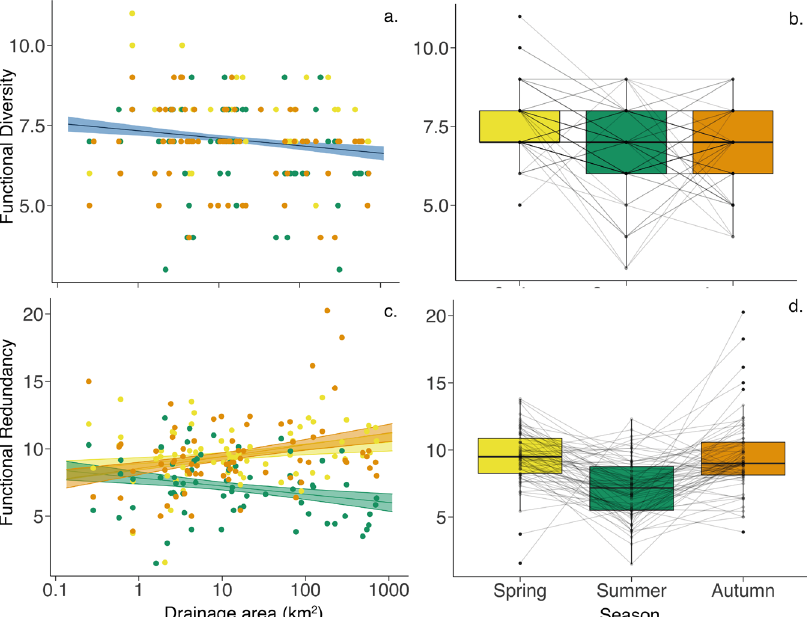
Fig. 5 Functional diversity and functional redundancy. Plots show functional dynamics: ( a , b ) functional diversity and ( c , d ) functional redundancy. Lines indicate linear mixed-effect models with shaded area showing 95% con fi dence intervals as calculated using the model predictions and standard error. Plot a shows no signi fi cant effect of the interaction between drainage area and season therefore the line indicates the model output of all the data as a function of drainage area which is marginally signi fi cant (blue). Plot c shows the model with a signi fi cant interaction with the difference across each season (colour represents season). Plots b and d show the change over season with samples sites linked by grey lines over the three sampling seasons. Colour represents season: yellow – Spring, green – Summer and orange – Autumn and blue – all seasons